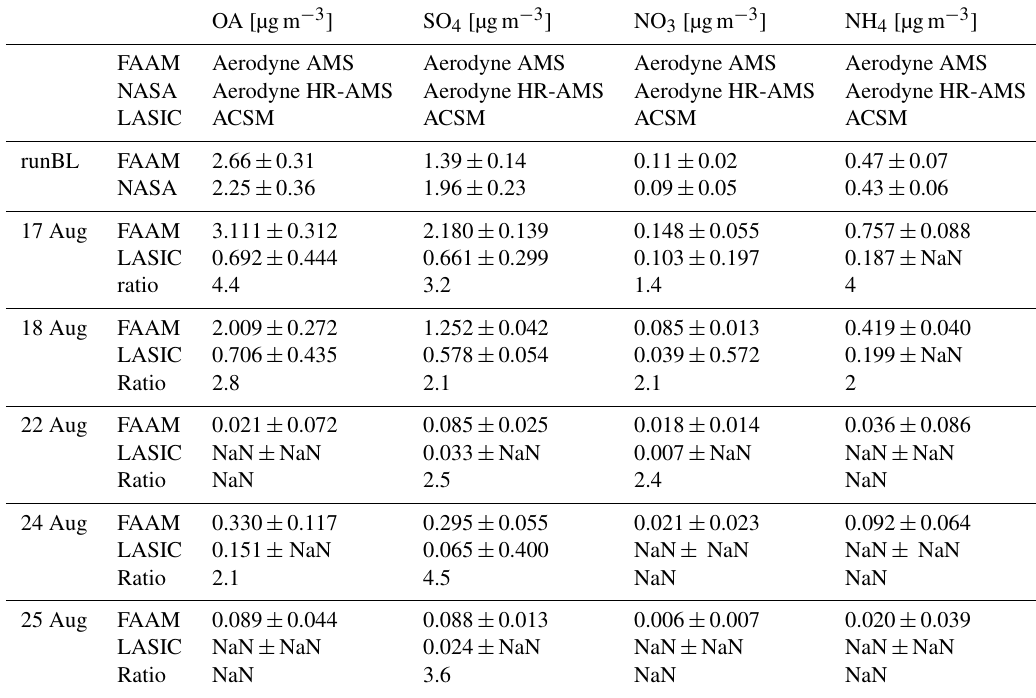
Table 4. Aerosol composition properties, organic aerosol (OA), sulfate (SO 4 ) , nitrate (NO 3 ) and ammonia (NH 4 ) for FAAM, NASA and LASIC platforms. Data are not available from 5 September. Missing data are represented as NaN (not a